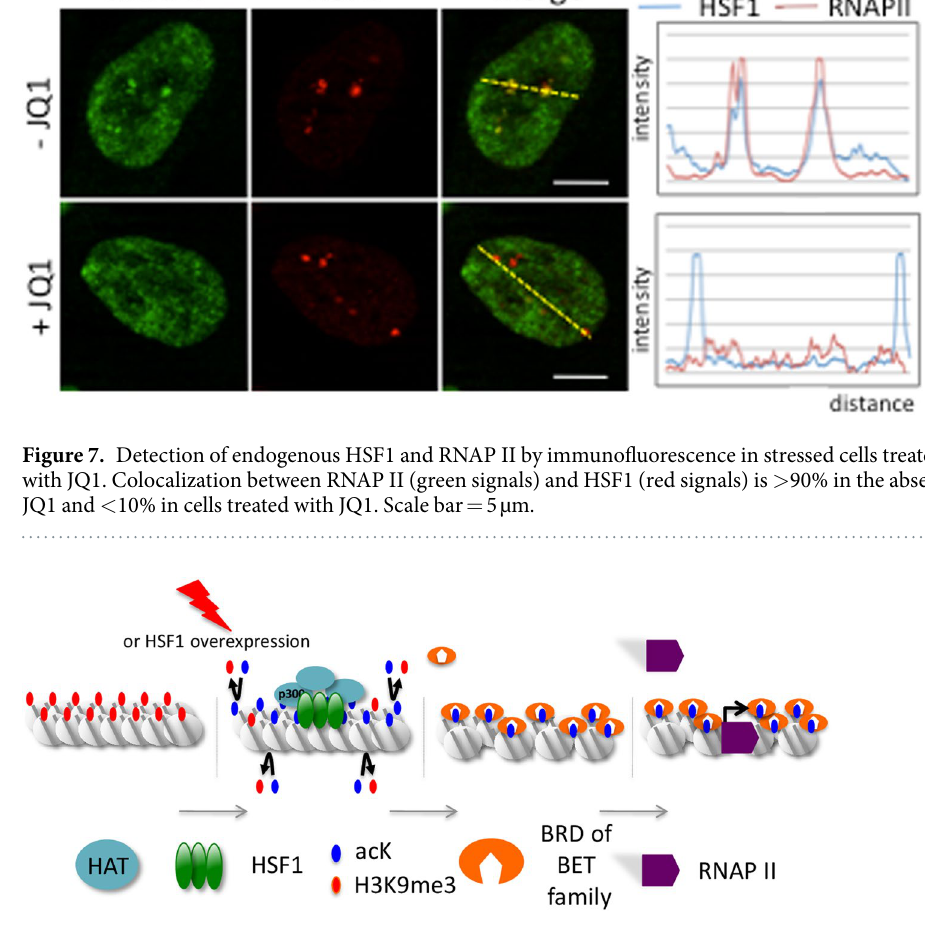
Figure 8. General scheme of sat III transcription at nSB. Heat shock allows a massive recruitment of several HATs to sat III sequences through their direct or indirect interaction with HSF1. Acetylated lysine residues of histones H3 and H4 then serve as docking sites for Bromodomain proteins of the BET family, triggering chromatin remodeling and RNAP II